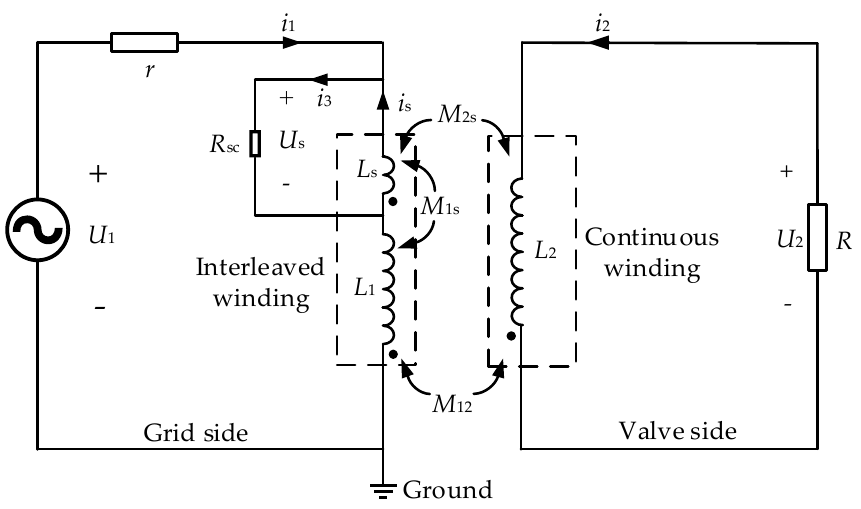
where U 1 , U 2 , i 1 and i 2 , are the port voltage and port current, respectively. U s and i s are the voltage and current of short circuit winding. M 12 , M 1s , and M 2s are the mutual inductance among windings. L 1 , L s , and L 2 are the self-inductance of windings. r is the internal resistance of power supply. R sc is a short circuit resistance connected in series on the short-circuit line to characterize different degrees of inter-turn short circuit. R sc is set to 0.01 Ω to indicate serious inter-turn short circuit.